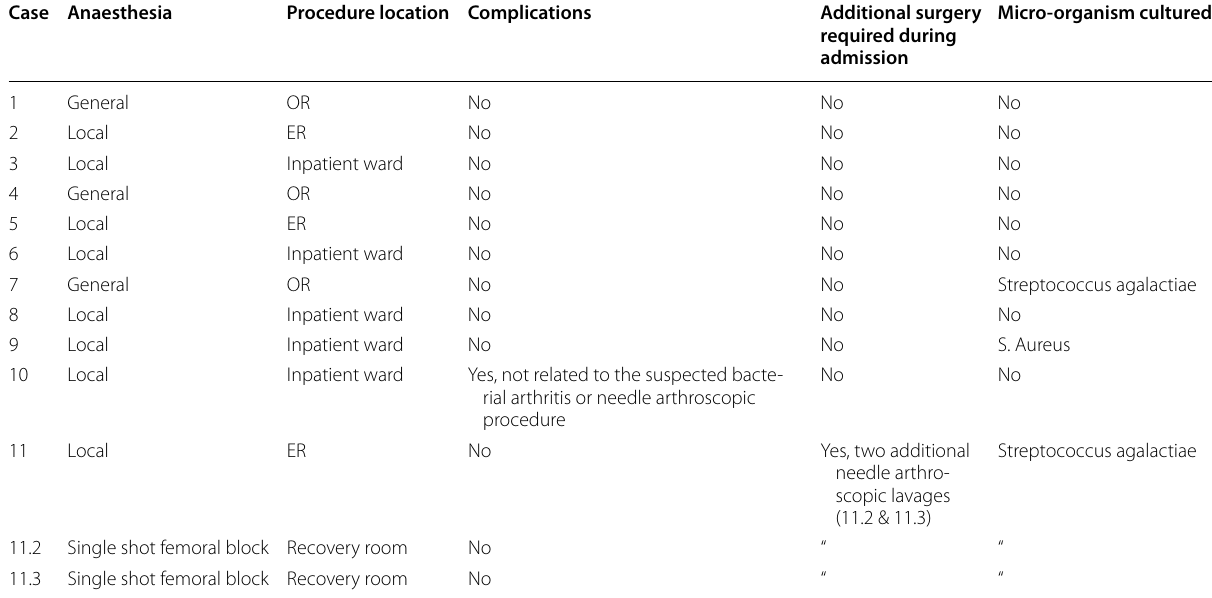
Table 2 Procedure characteristics and outcome Case Anaesthesia Procedure location